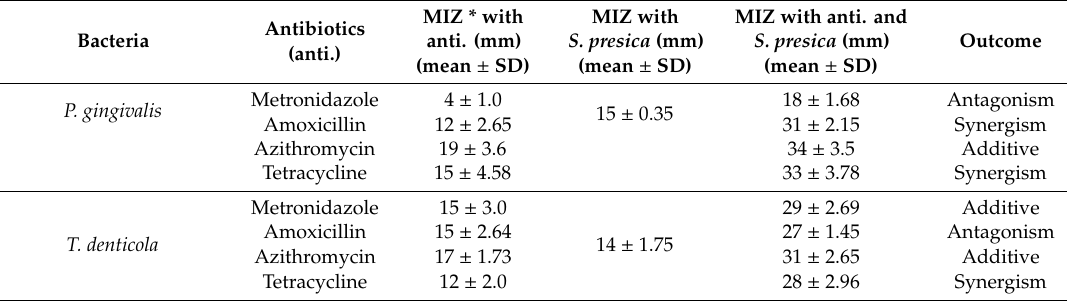
Table 4. Synergistic antimicrobial activity of S. presica with di ff erent antimicrobial